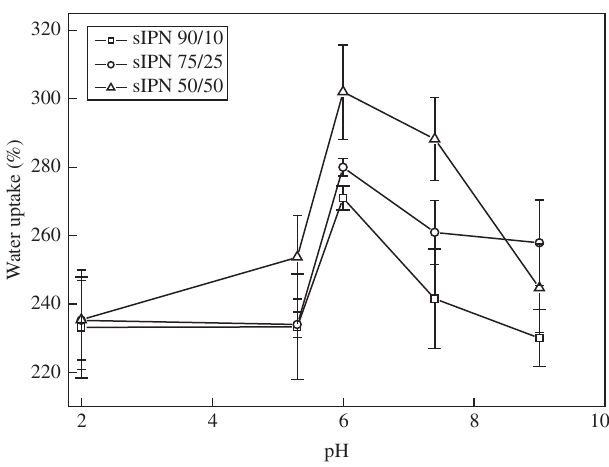
Figure 2. Equilibrium water uptake (WU) of the s-IPN PVA/PES hydrogels in various pH buffer solutions at 25